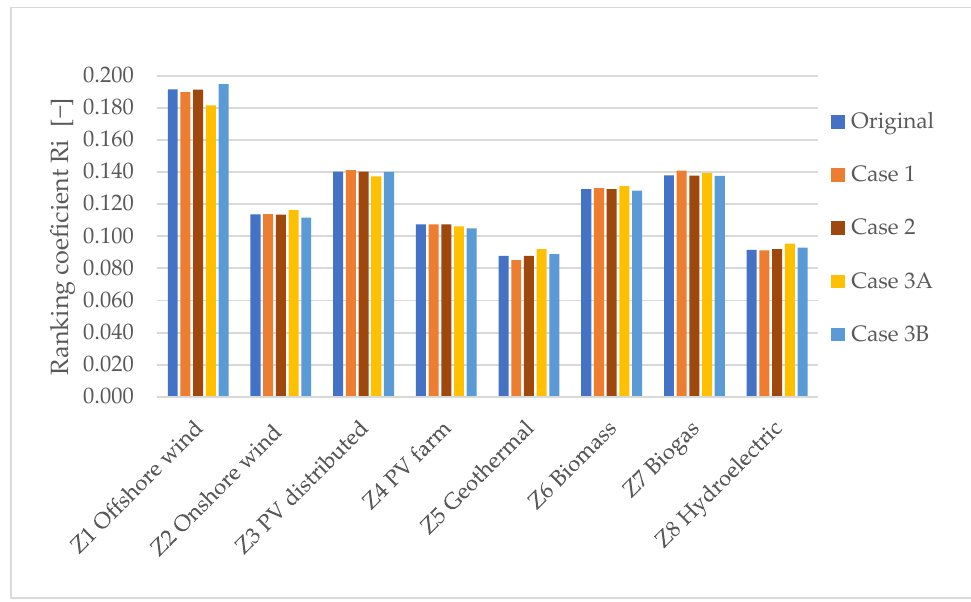
Figure 4. The impact of the input data alterations on the ranking coefficient, Cases 1 – 3 versus original case.